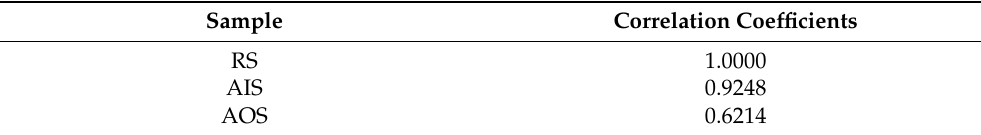
Table 3. Correlation coefficients for the comparison of AOS and AIS with RS between 1800 and 800 cm − 1